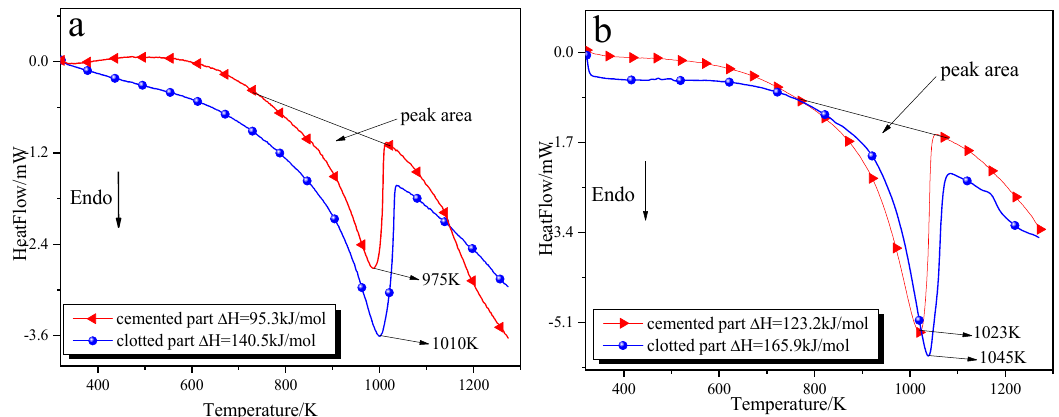
Figure 6. Heat flow changes of cemented and clotted parts. ( a ) The heat flow changes of cemented and clotted parts at heating rate of 5 K / min; ( b ) the heat flow changes of cemented and clotted parts at heating rate of 10 K / min.